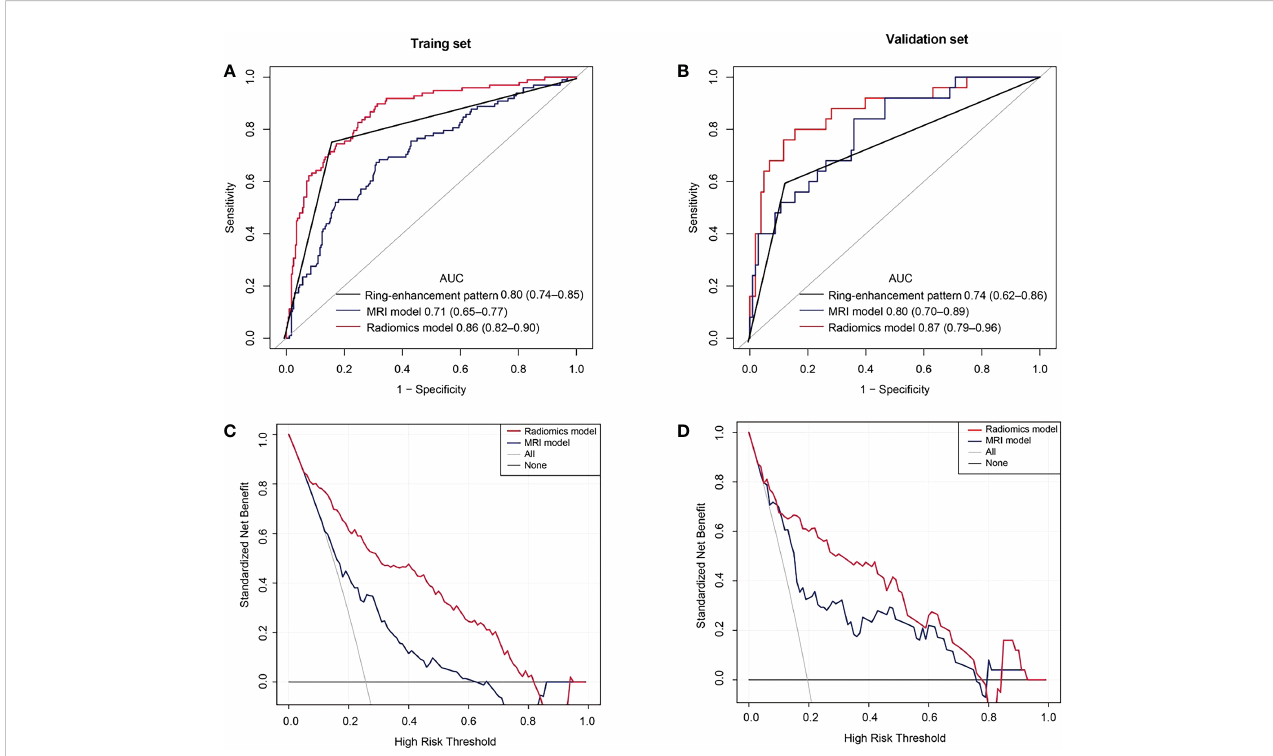
FIGURE 6 Receiver operating characteristic (ROC) and decision curve analysis (DCA) curves. (A) ROC curves in the training set. (B) ROC curves of the validation set. (C) The DCA curves of the training set. The y-axis represents the net bene fi t. The red line represents the radiomics model. The blue line represents the MRI model. The black line represents the hypothesis that all patients had pancreatic adenosquamous carcinoma (PASC). The gray line represents the hypothesis that all patients had pancreatic ductal adenocarcinoma (PDAC). The decision curves show that with a threshold probability between 0.05 and 0.81, using the radiomics model to predict PASC in the training set added more bene fi t than the treat-all-patients as a PDAC scheme or the treat-none as a PASC scheme. (D) The DCA curves show that with a threshold probability between 0.02 and 0.78, using the radiomics model to predict PASC in the validation set provided more bene fi ts than the treat-all-patients as a PDAC scheme or the treat-none as a PASC